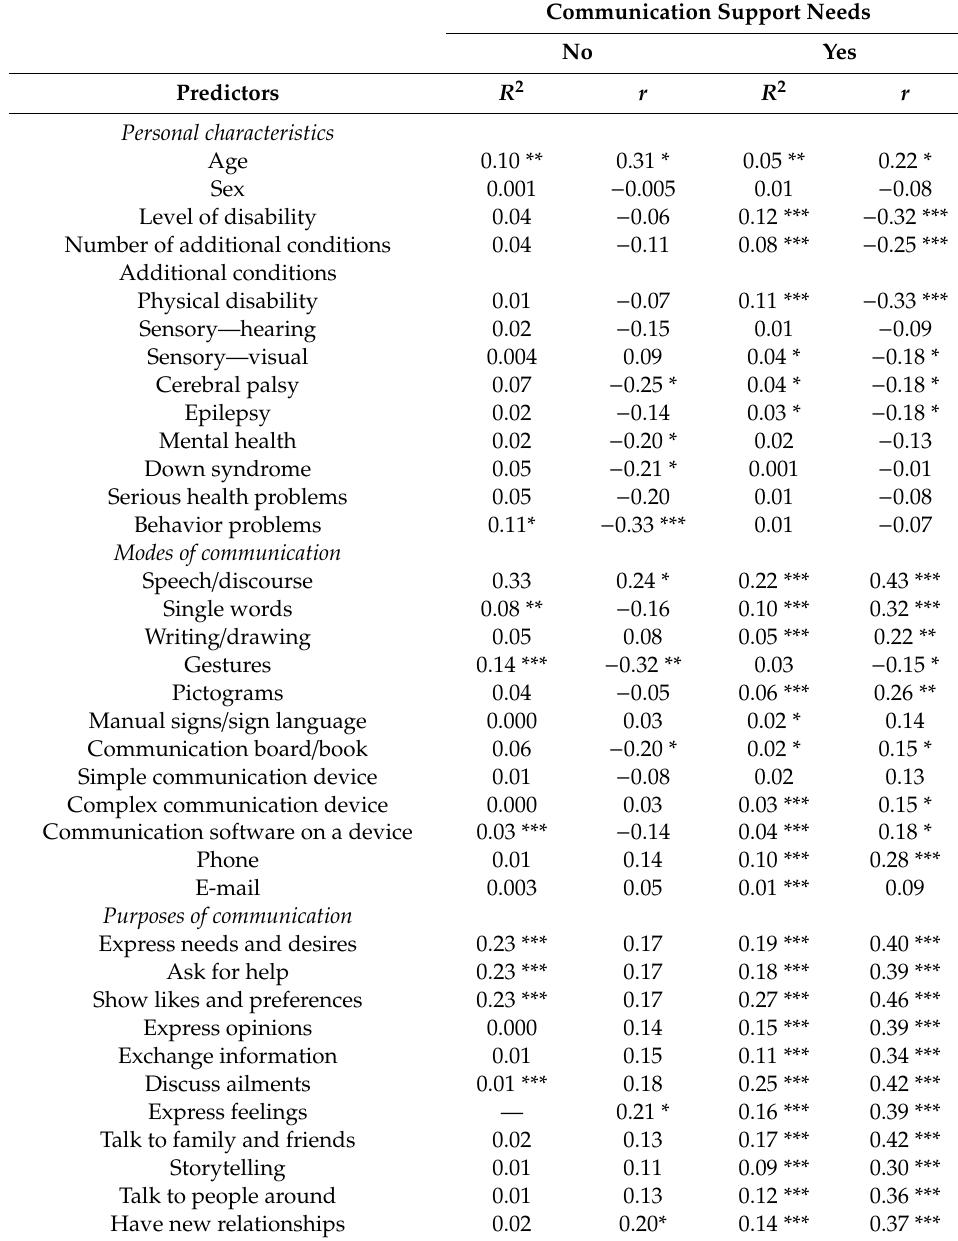
Table 5. Results of bivariate robust regression analyses and correlation coe ffi cients with Quality of Life Index by